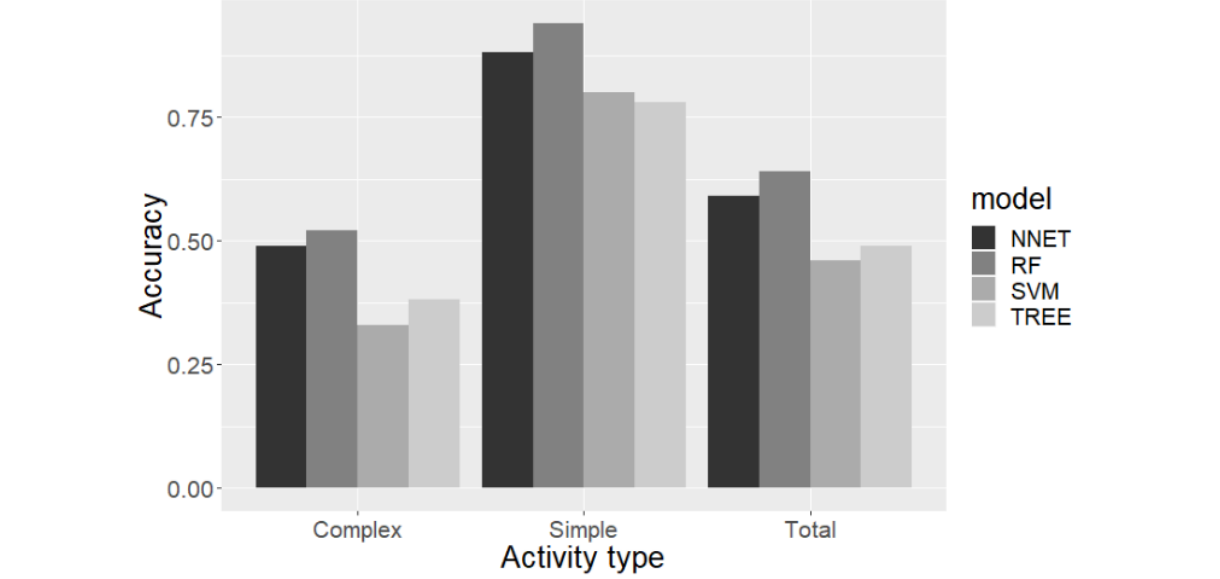
Figure 8. Comparison of the performance of different classifiers for activity recognition task, in terms of overall accuracy for simple tasks, complex tasks, and total set of tasks. TREE: decision tree model, NNET: neural network model, RF: random forest model, and SVM: support vector machines model.